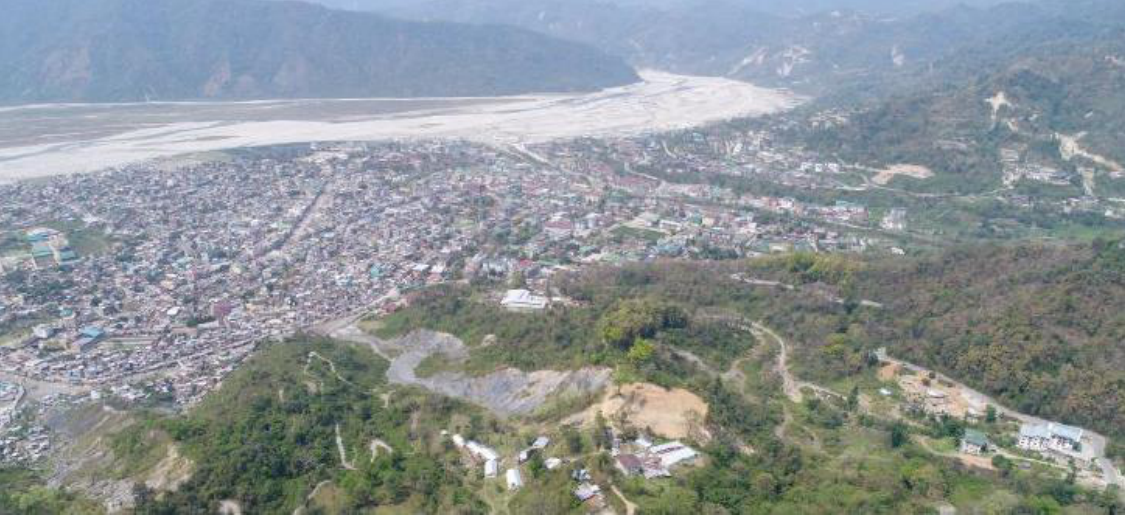
Figure 4. Arial view of Phuentsholing city, Bhutan [48].